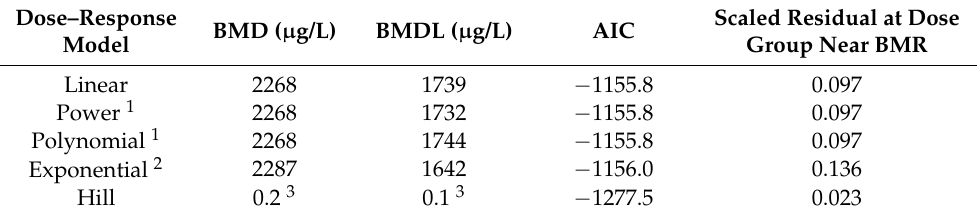
Table 4. BMD and BMDL estimates for PFOS for the SBA endpoint.